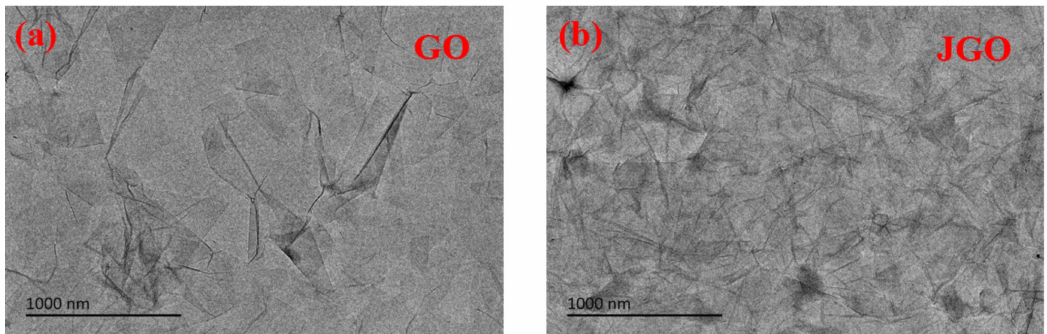
Figure 2. TEM images of GO ( a ) and JGO ( b